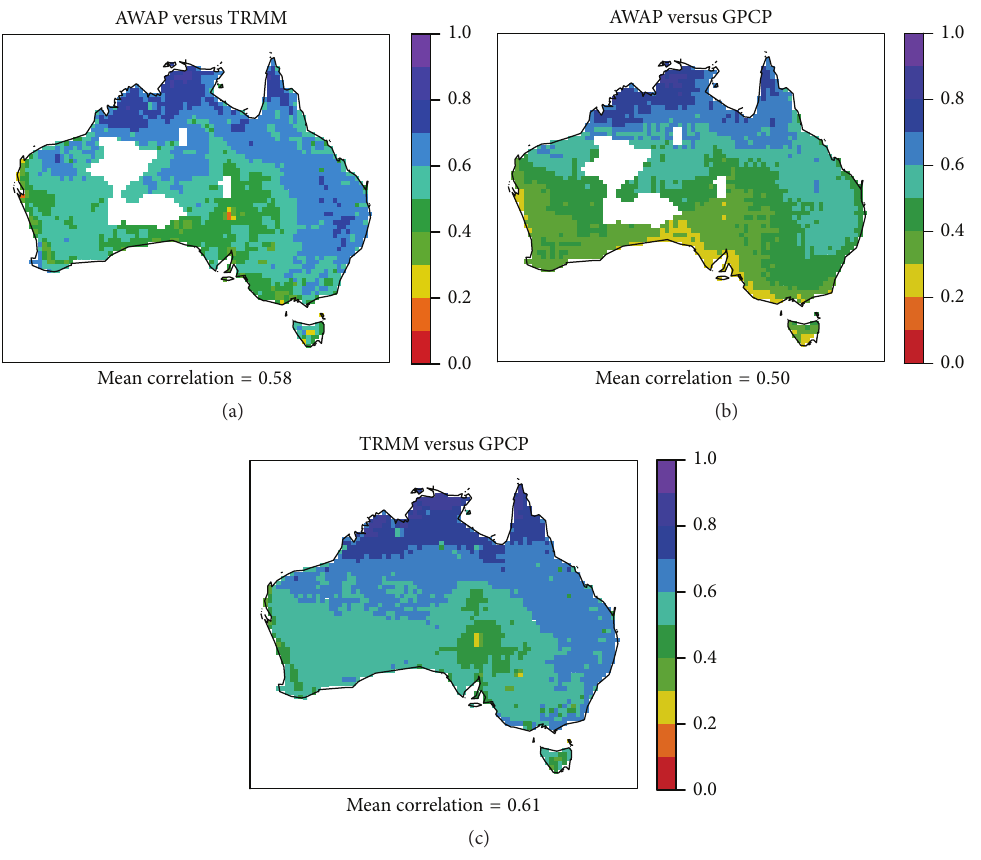
Figure 4: Maps of correlations of daily precipitation over the period of 1998 to 2013 at each grid point in Australia. Correlations between AWAP and TRMM are shown in (a), AWAP and GPCP in (b), and TRMM and GPCP in